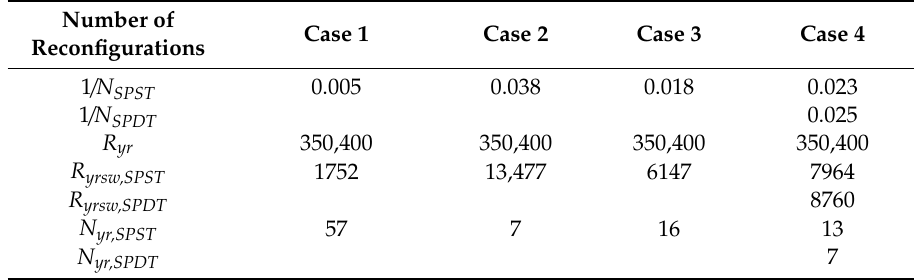
Table 6. Estimated number of reconfigurations per year and endurability of the switches in the four cases, for the “worst case”